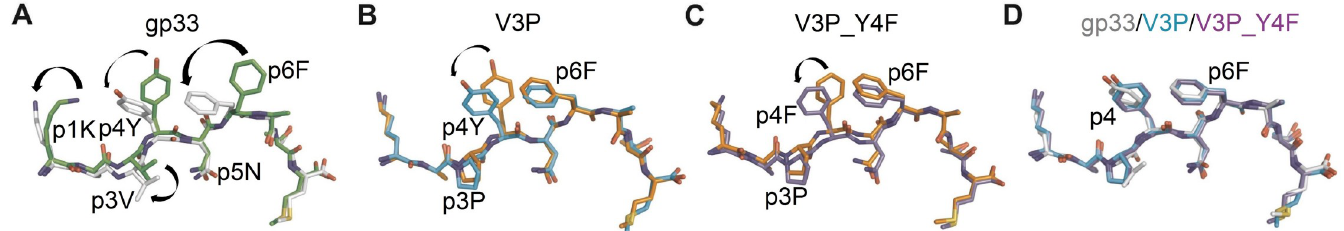
Fig 4. The p3P modification results in conformational changes of peptide residues p1K and p6F, predisposing pMHCs for optimal binding to P14. A. Comparison of gp33 before binding (in green) and after binding (in white) to P14 reveals major conformational changes in gp33 following binding to P14. These include a movement of the p2-p4 backbone of gp33 that is pushed down in the cleft combined with a 180 degrees rotation of the isopropyl moiety in residue p3V. Furthermore, the side chain of peptide residues p1K, P4Y and p6F all take new conformations following binding to P14. All movements are indicated by blue arrows. B. The introduction of p3P in V3P results in optimal positioning of the side chains of residues p1K and p6F prior to binding to P14 (in orange). The only observed conformational difference was taken by residue p4Y following V3P binding to P14 (in cyan). C. Similarly to V3P, the only conformational difference observed for V3P_Y4F before (in orange) and after (in violet) binding to P14 is at peptide residue p4Y. D. Peptides gp33 (in white), V3P (in cyan) and V3P_Y4F (in violet) take nearly identical conformations when bound to P14.